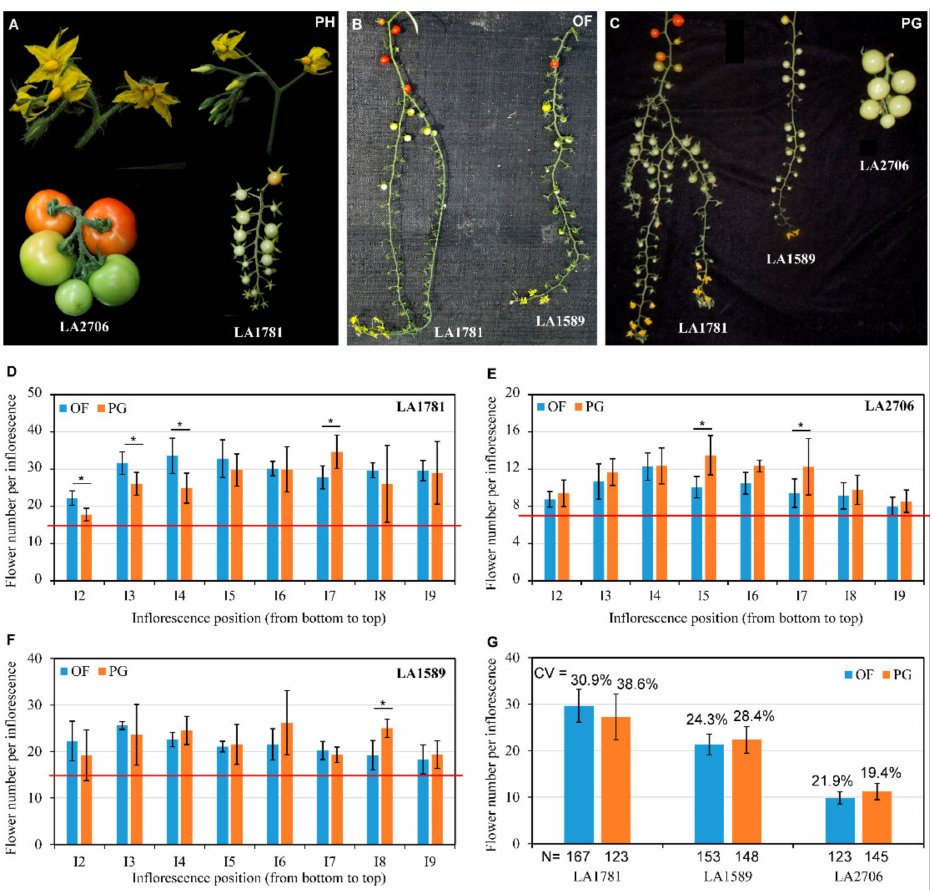
Figure 1. The plasticity of inflorescence development in three genotypes. ( A ), Representative inflores- cences bearing flowers or fruits of LA1781 and LA2706 grown in phytotron (PH). ( B ), Inflorescences of LA1781 and LA1589 grown in open field (OF). ( C ), Inflorescences of LA1781, LA1589 and LA2706 grown in plastic greenhouse (PG). ( D ), Flower numbers per inflorescence on LA1781 plants grown in open field (OF) and plastic greenhouse (PG). ( E ), Flower numbers per inflorescence on LA2706 plants grown in open field (OF) and plastic greenhouse (PG). ( F ), Flower numbers per inflorescence on LA1589 plants grown in open field (OF) and plastic greenhouse (PG). ( G ), Averaged flower numbers on the 2nd to 9th inflorescences from plants grown in open field (OF) and plastic greenhouse (PG). Flowers were counted from the 2nd to 9th inflorescence on each plant. The data were collected from plants grown in four different blocks in an open field and four units of a plastic greenhouse, the number of plants investigated are indicated in ( G ). The red lines in ( D – E ) indicate the means of flower number per inflorescence from plants grown in phytotron (PH). CV, coefficient of variations. Error bars in ( D – F ) represent standard deviations of means. *, p -value ≤ 0.05 based on Student’s t